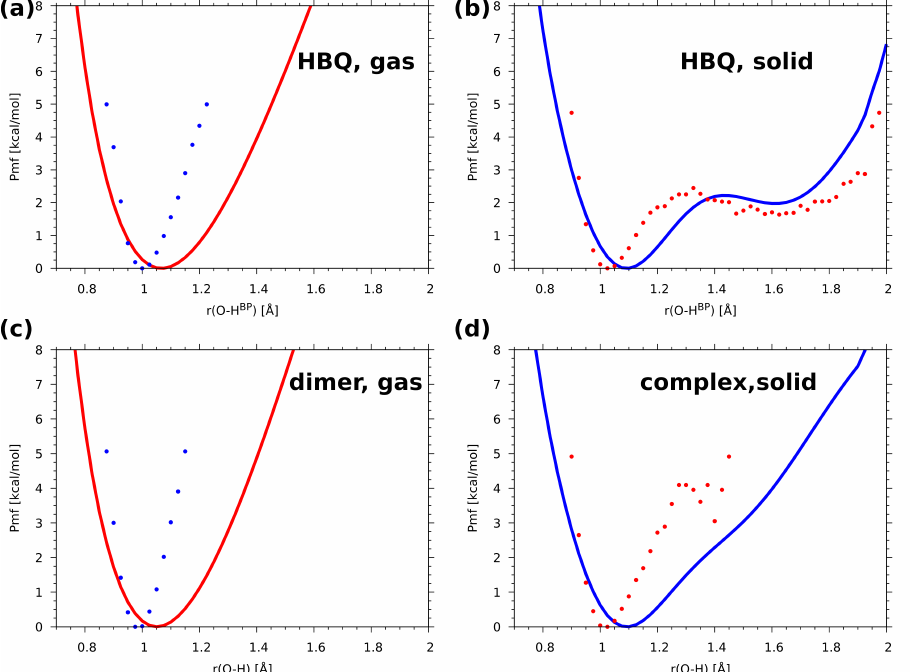
Figure 7. Comparison of the potential of mean force (Pmf) from the CPMD trajectory with classical nuclei (shown with circles) and with inclusion of a posteriori quantum corrections (drawn with lines) for proton motion in the investigated O-H...N hydrogen bridges ( a ): HBQ in the gas phase, ( b ): HBQ in the crystal, ( c ): the benzo[h]quinoline-2-methylresorcinol complex in the gas phase, ( d ): the complex in the